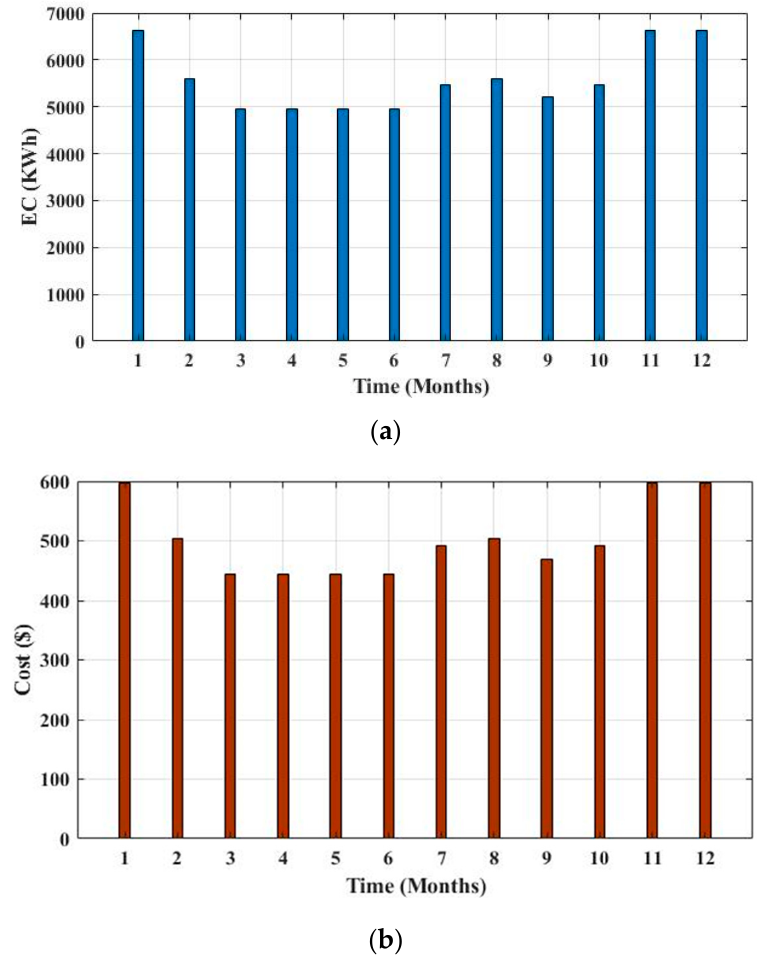
Figure 9. ( a ) EC and ( b ) energy cost of NF-II control system.